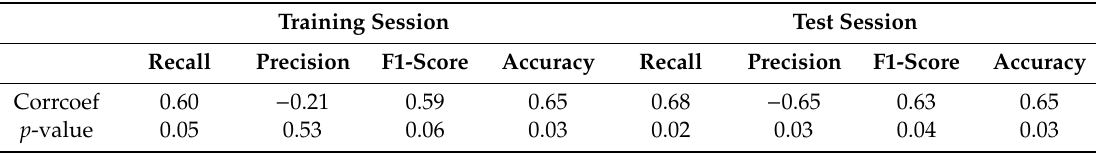
Table 3. Correlation of BCI system accuracy with other performance indices. Corrcoef: Correlation Coefficient. Accuracy is the result of binary classification that classifies target and nontarget. Training